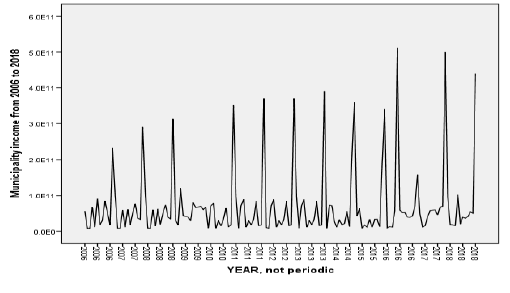
Figure 4. Reviewing Municipality Revenue Charts in terms of Months (1)